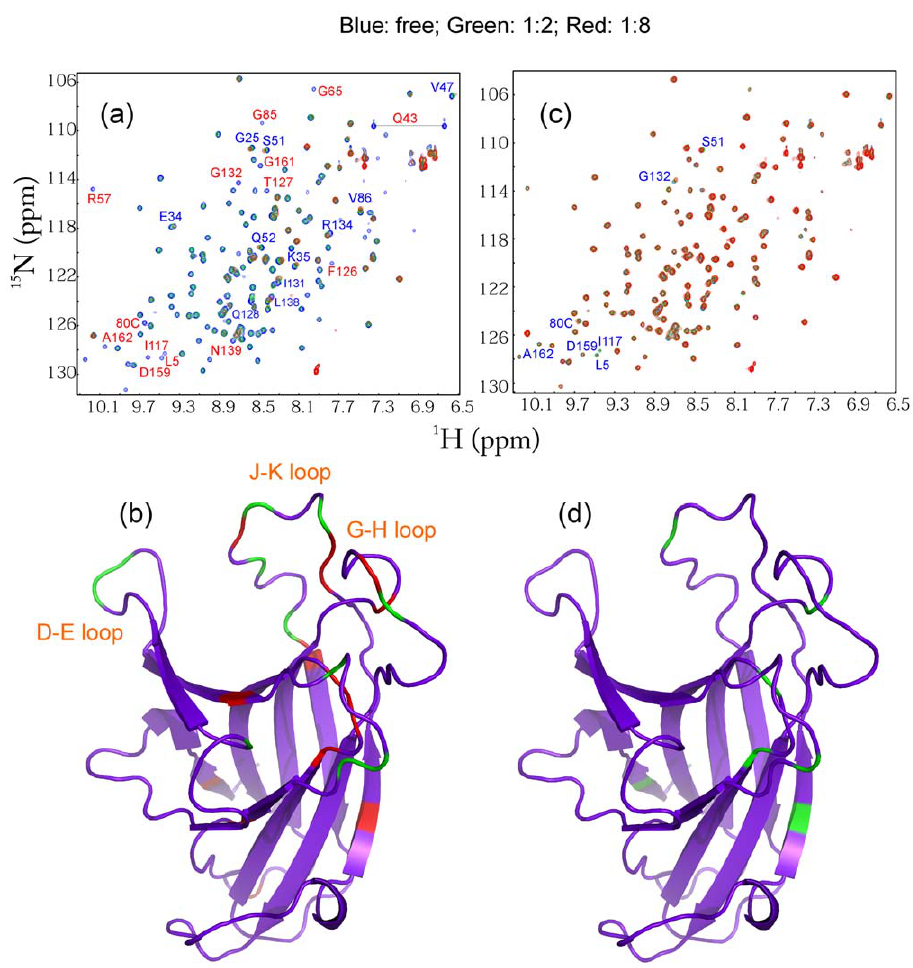
Figure 5. Interaction between EphA4 and WT-/T46I-MSP domain. Superimposition of the two-dimensional 1 H- 15 N NMR HSQC spectra of the EphA4 ligand binding domain in the absence (blue) and presence of the WT- (a) and T46I- (c) MSP domains at molar ratios 1:2 (green) and 1:8 (red) (EphA4/MSP). Red letters are used to label residues with disappeared HSQC peaks while blue for residues with shifted peaks. Crystal structure of the EphA4 ligand-binding domain we previously determined ( 37 ) with the perturbed residues mapped back for the interaction between EphA4 and WT- MSP (b), and T46I-MSP (d). Blue is to indicate residues with unperturbed HSQC peaks, while green and red for residues with shifted and disappeared peaks respectively.